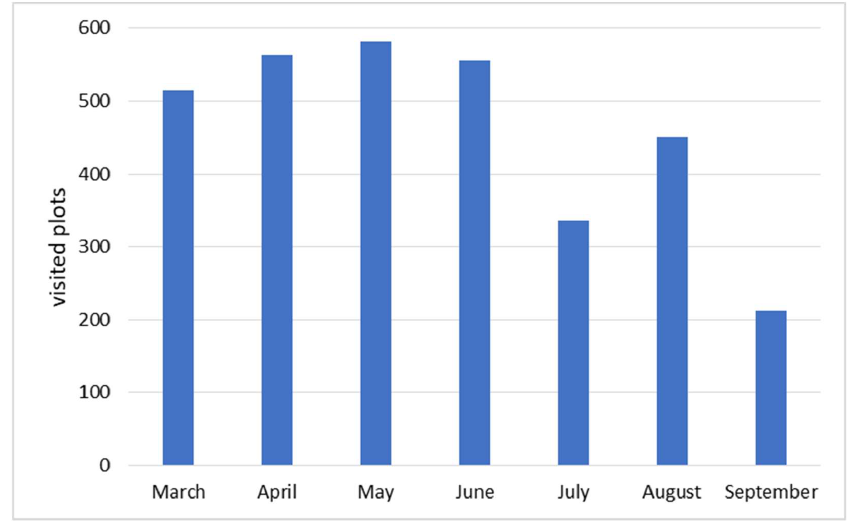
Figure 5. Number of parcels visited per month during the 2019 crop cycle. lected and used to train the classifier, with the remaining 140 (50%) plots used for valida- tion. (b) Sampling unit taken from satellite images